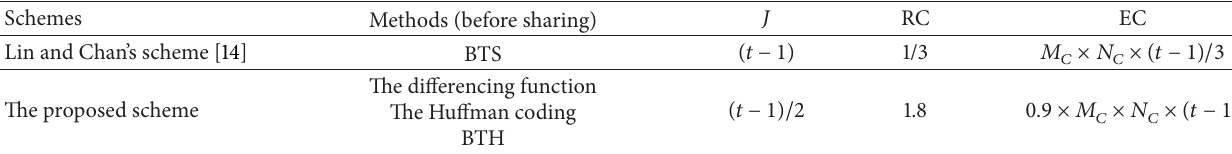
Table 3: The comparison of the embedding capacity.